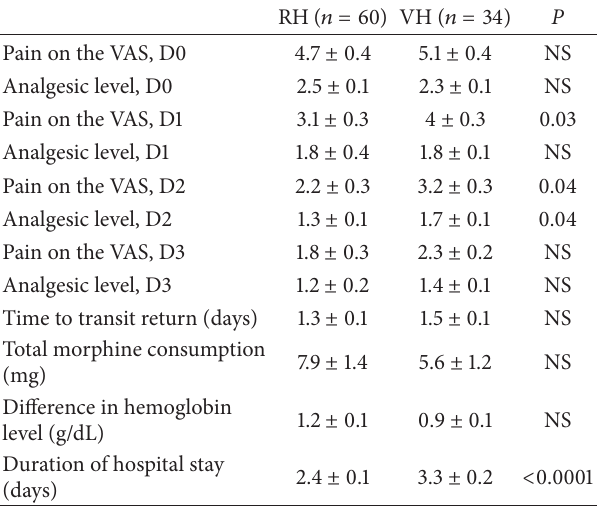
Table 3: Postoperative results expressed as mean ± SD and number (%).